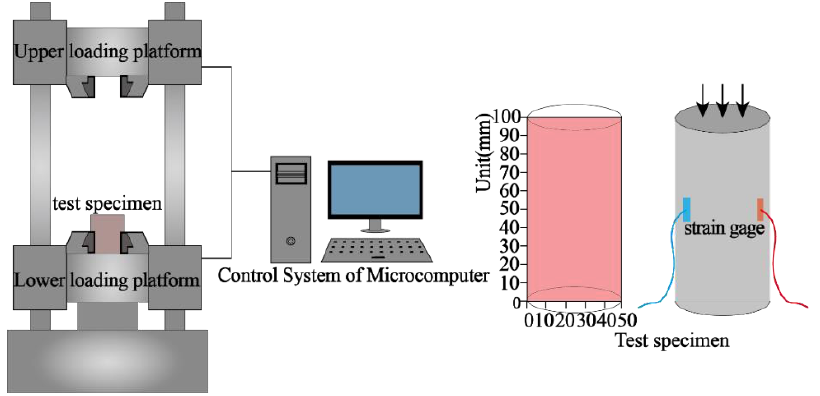
Figure 3. WGE-600 microcomputer control screen display universal investigation machine. Experi- Figure 3. WGE-600 Experiment and investigation equipment with microcomputer control displaying ment and investigation equipment with microcomputer control displaying of WGE-600 of